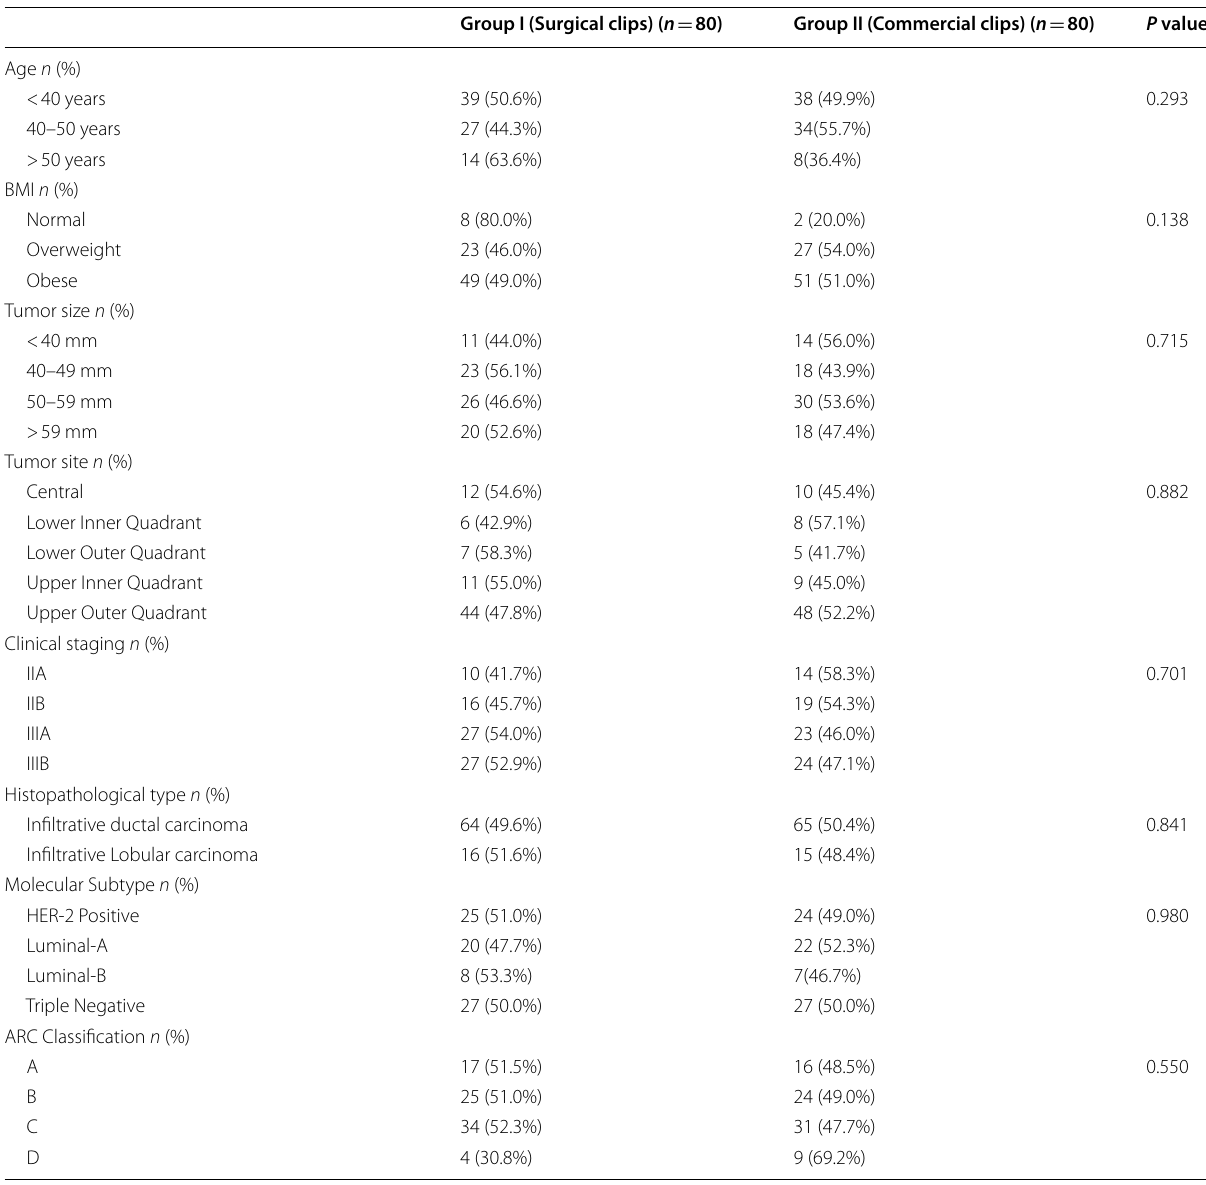
Table 1 Demographic and preoperative clinical data of the patients